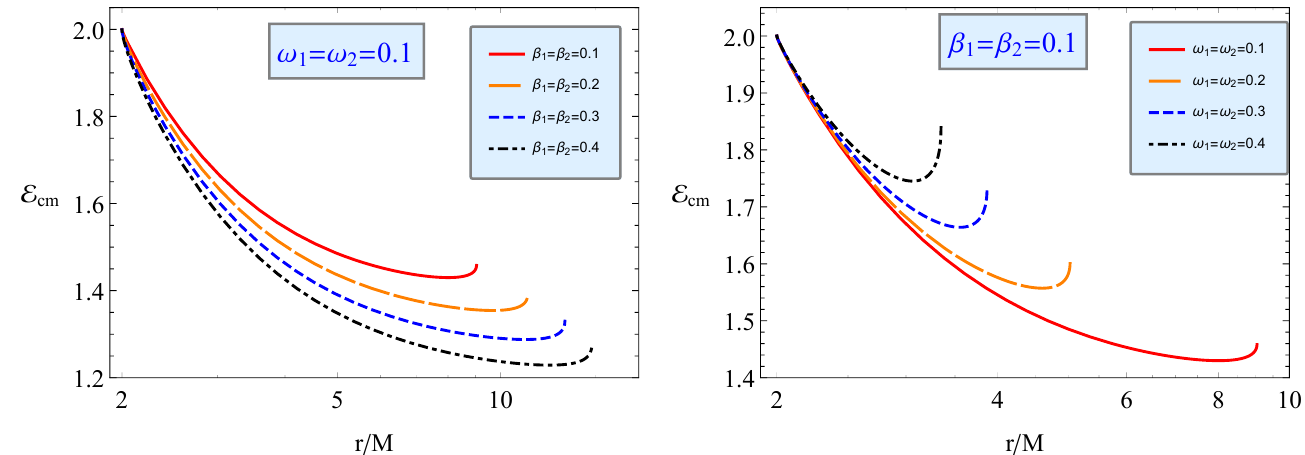
Figure 14. The same as Figure 9 but for the collisions of two positively charged particles with a magnetic dipole for different values of ω B ( left panel ) and β ( right panel